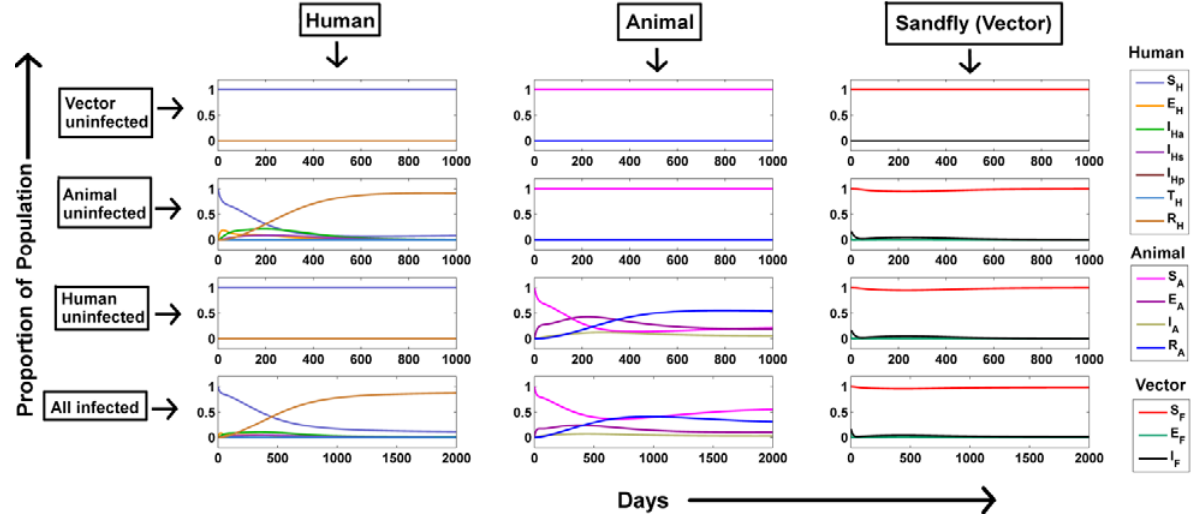
Figure 2. Numerical simulations of the model were performed in the vector uninfected, animal uninfected, human uninfected and all infected scenarios for every variable (in the human, animal and sandfly compartments) considered in the model and the temporal behavior of the system was monitored for each population